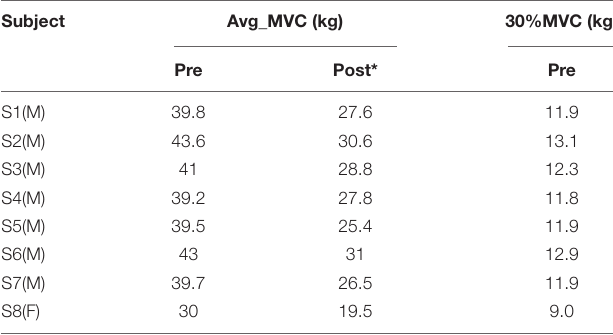
TABLE 1 | maximum voluntary contractions for all